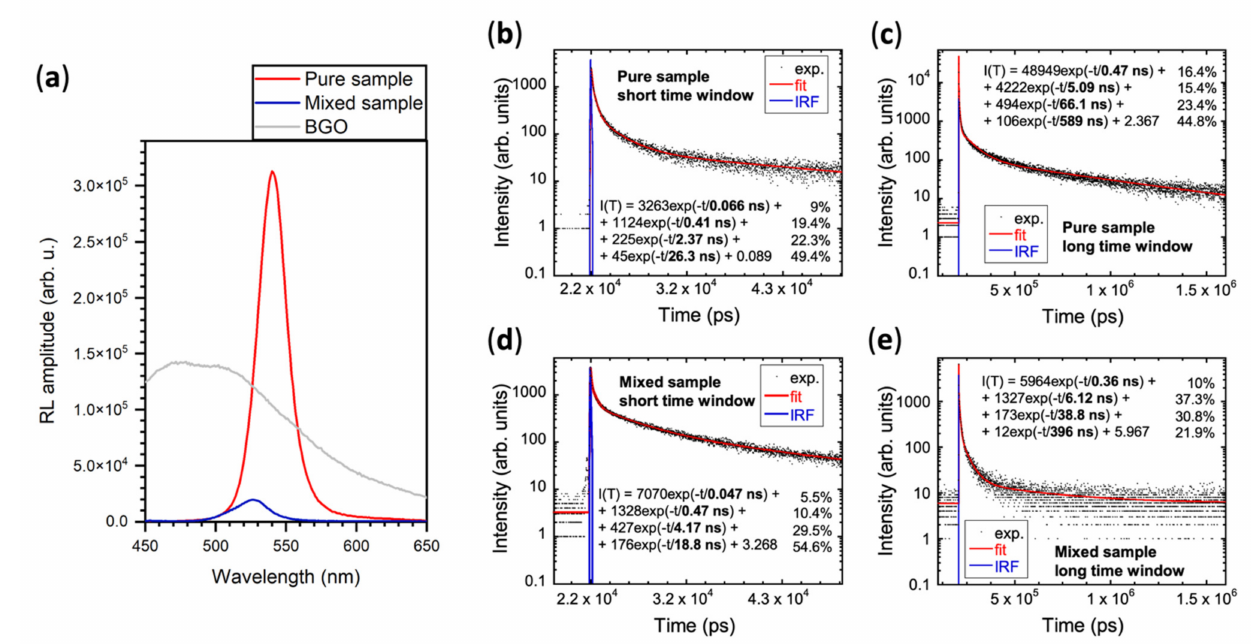
Figure 5. ( a ) Radioluminescence (RL) spectra of the pure sample (red line) and of the mixed sample (blue line) compared to the RL spectrum of Bi 4 Ge 3 O 12 (BGO) powder (grey line); ( b – e ) scintillation decay curves for both the pure ( b , c ) and mixed ( d , e ) samples, recorded in both the short ( b , d ) and long ( c , e ) time windows. Black dots represent the experimental data, red line is the best fit (4-exponential function), and blue line is the instrumental response function